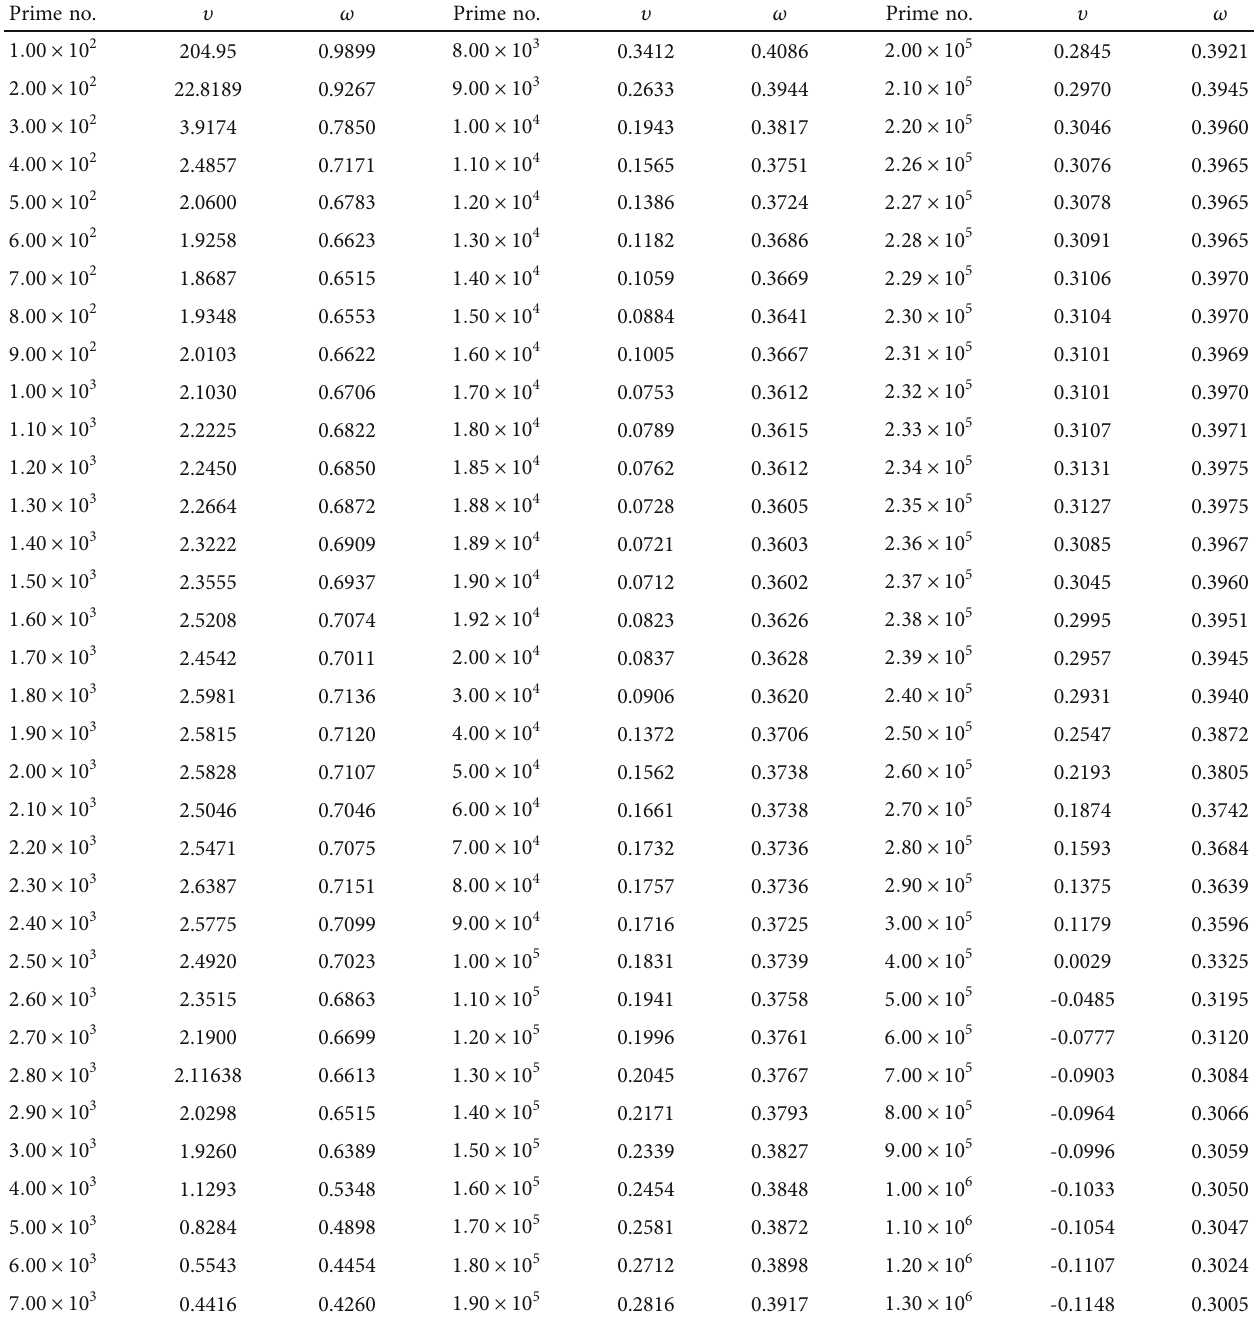
Table 2: The calculated parameters for the inverse χ 2 distribution ( υ ) and Brody distribution ( ω ) starting from 100 to 1.3 million primes. Prime